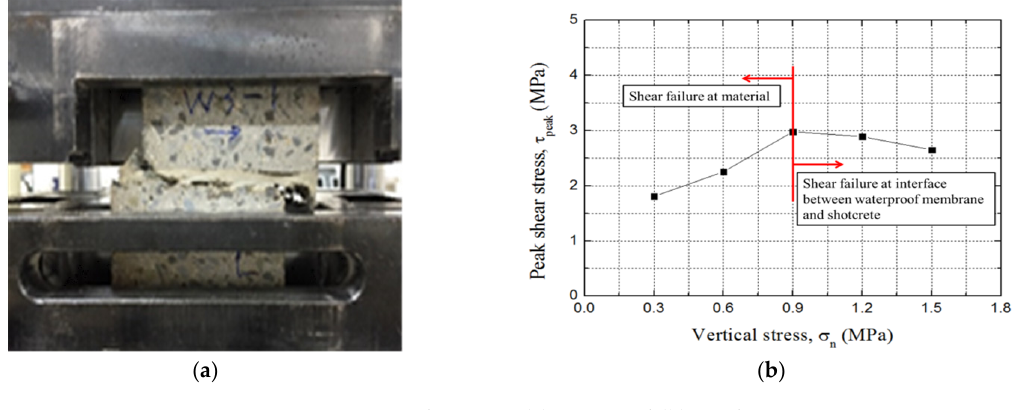
Figure 4. Direct shear test: ( a ) setup and ( b ) results.